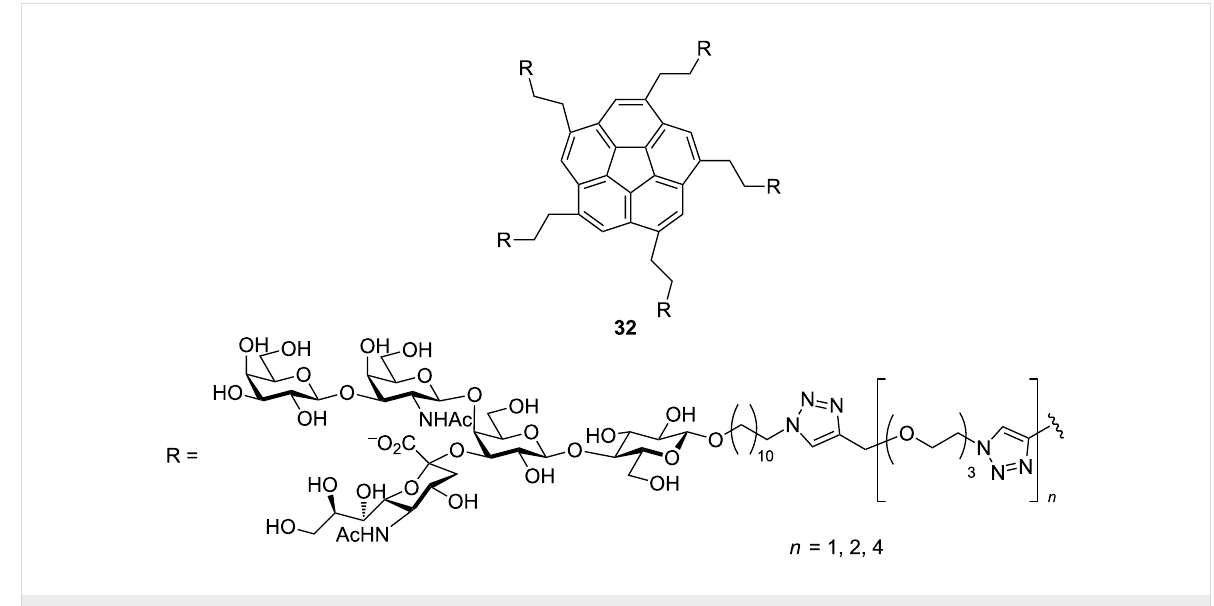
Figure 13: Corannulene core-based pentavalent inhibitor designed by Mattarella et al.